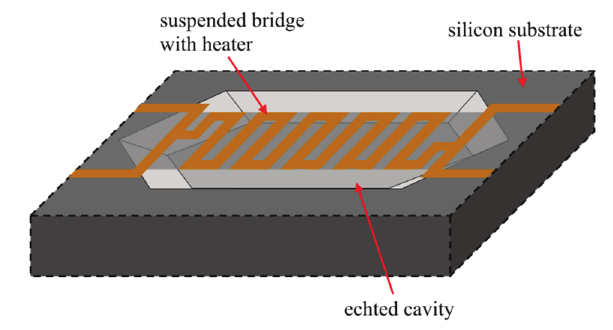
Fig. 3. Simplified setup of thermal